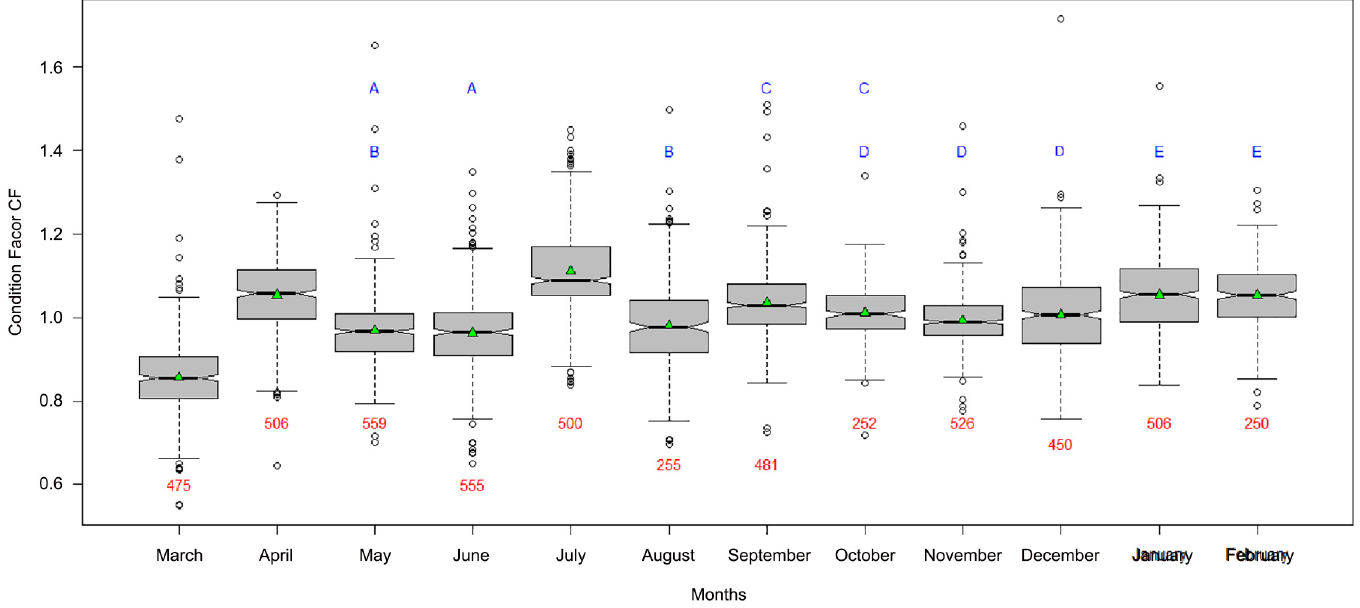
Fig 3. Condition Factor (CF) for Sardinella maderensis from March 2012 to February 2013. Means are represented by green triangles inside the notched box plots. Red figures under the error bars are the sample sizes. Months with the same blue letters (A-E) are not significantly different according to the Kruskal-Wallis